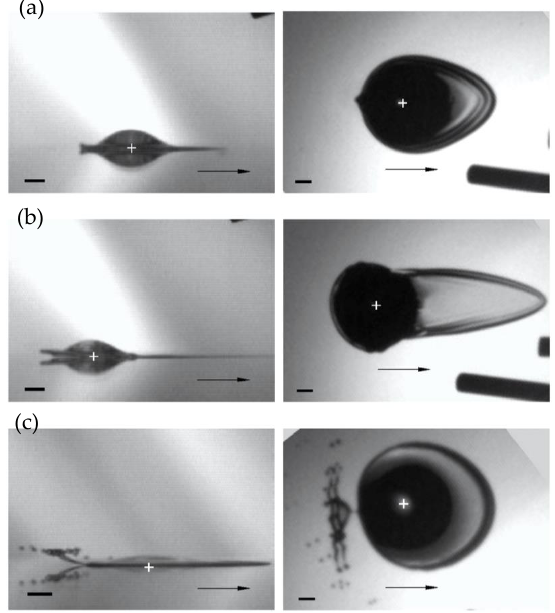
Figure 9. Side ( Left ) and top ( Right ) view of droplet deformation on a moving surface showing ( a ) deposition, ( b ) partial lift off, and ( c ) partial lift off with side-splash; scale bar is 1mm (reproduced with permission from [86]).